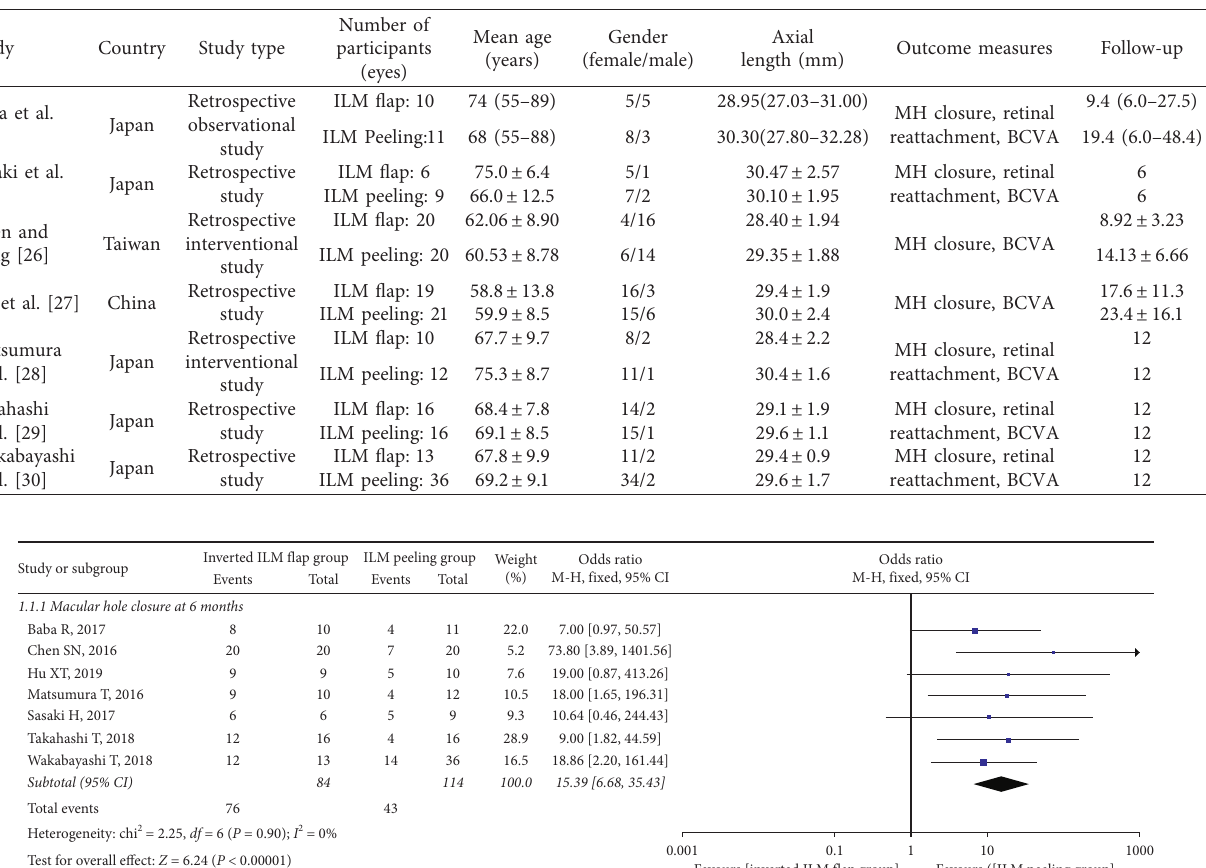
Table 1: The baseline patient characteristics of the included studies.